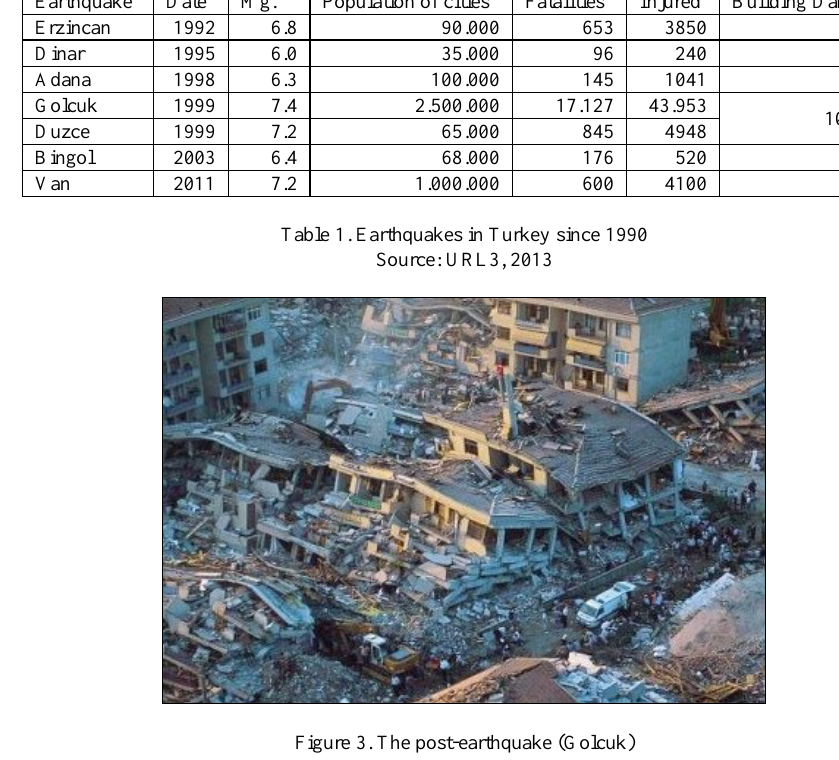
Figure 3. The post-earthquake (Golcuk) Source: URL4,